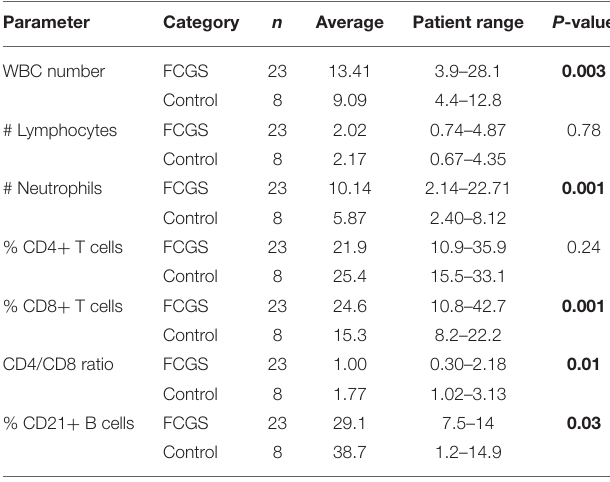
TABLE 3 | Differential cell counts in the peripheral blood of FCGS patients compared to healthy